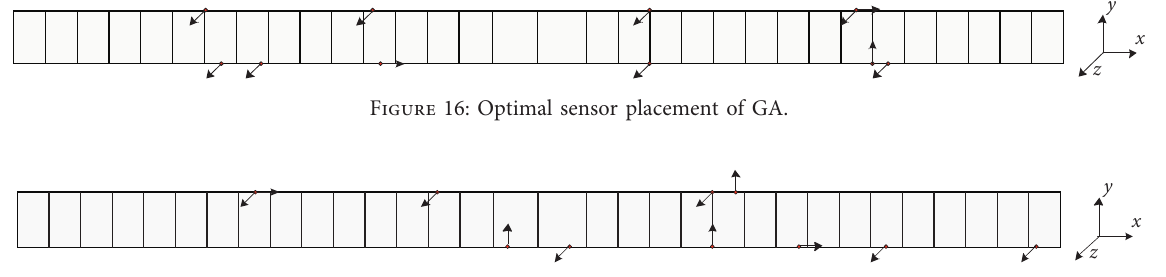
Figure 17: Optimal sensor placement of PSO.